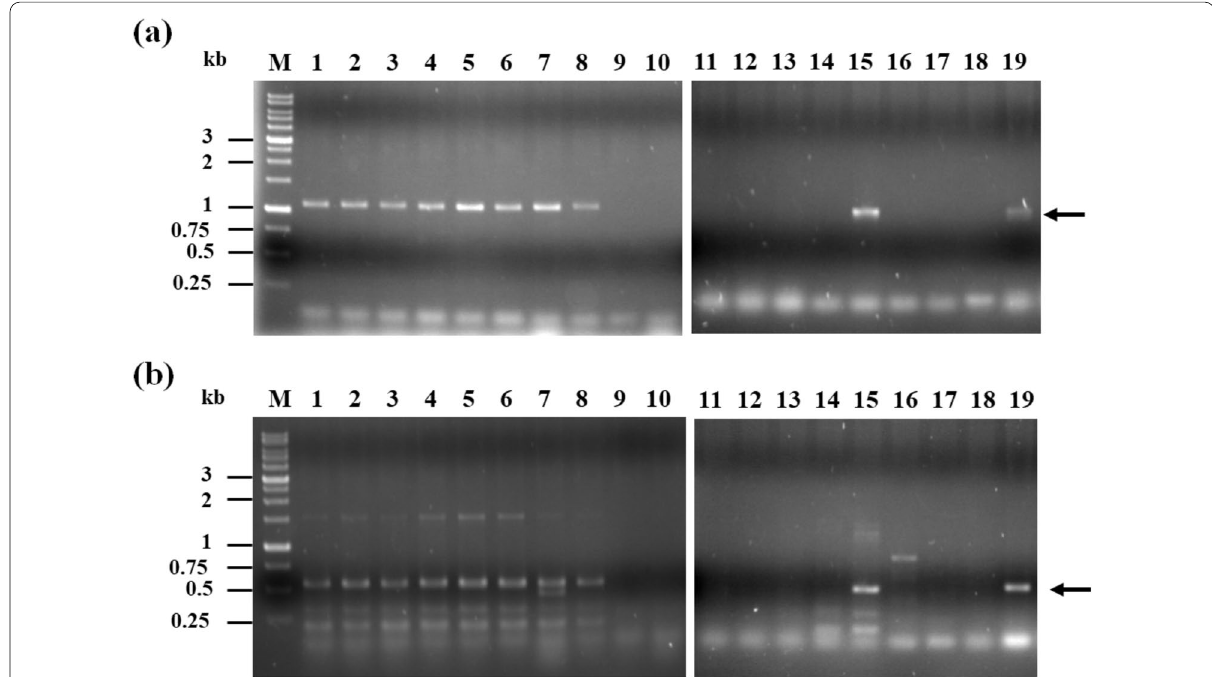
Fig. 1 PCR analyses of monacolin K‑related genes. The partial mokA ( a ) and mokE ( b ) genes were detected. Lanes 1–19 revealed M. pilosus BCRC 31502, and 38072; M. ruber BCRC 31533, 31523, 31534, 31535, 33314, and 33323; M. purpureus BCRC 31542, 31541, 33325, and 31615; M. kaoliang BCRC 31506; M. sanguineus BCRC 33446; M. barkeri BCRC 33309; M. floridanus BCRC 33310; M. lunisporas BCRC 33640; M. pallens BCRC 33641; A. terreus BCRC 32670. The arrows indicated the expected DNA bands by